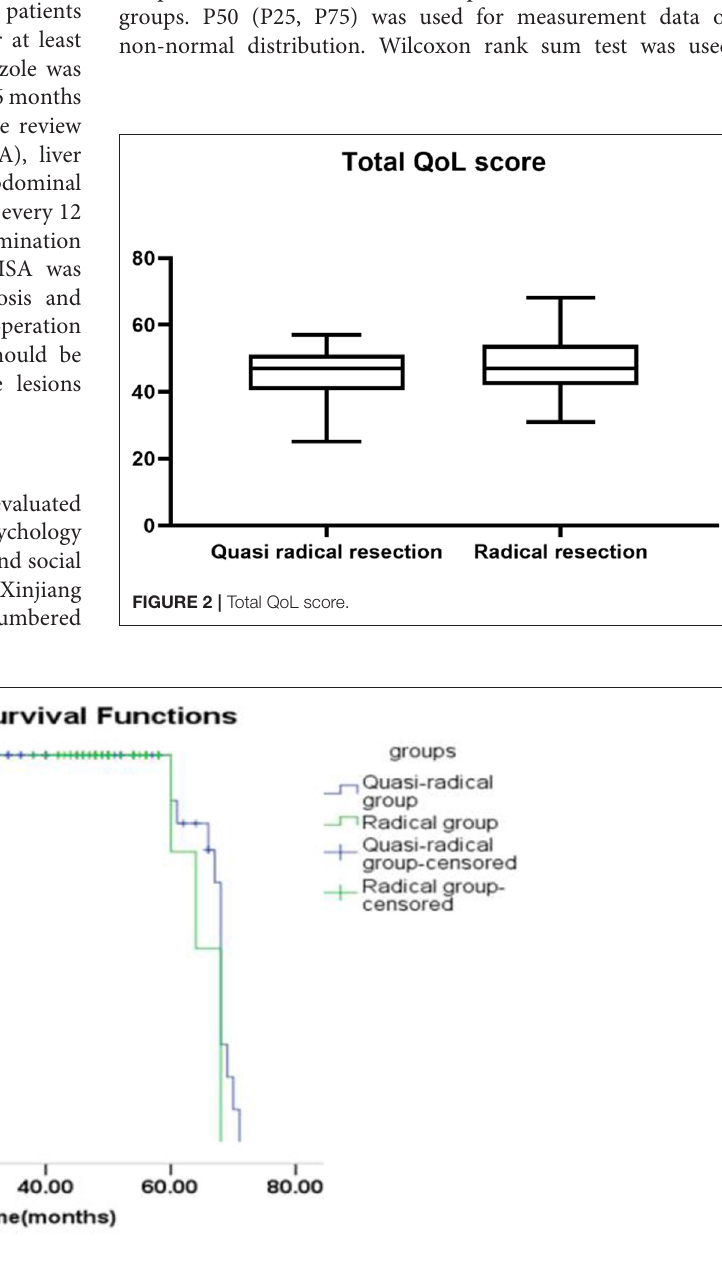
Frontiers in Surgery |